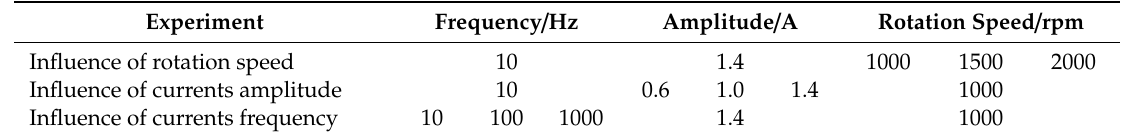
Table 3. Overview of the experiments.